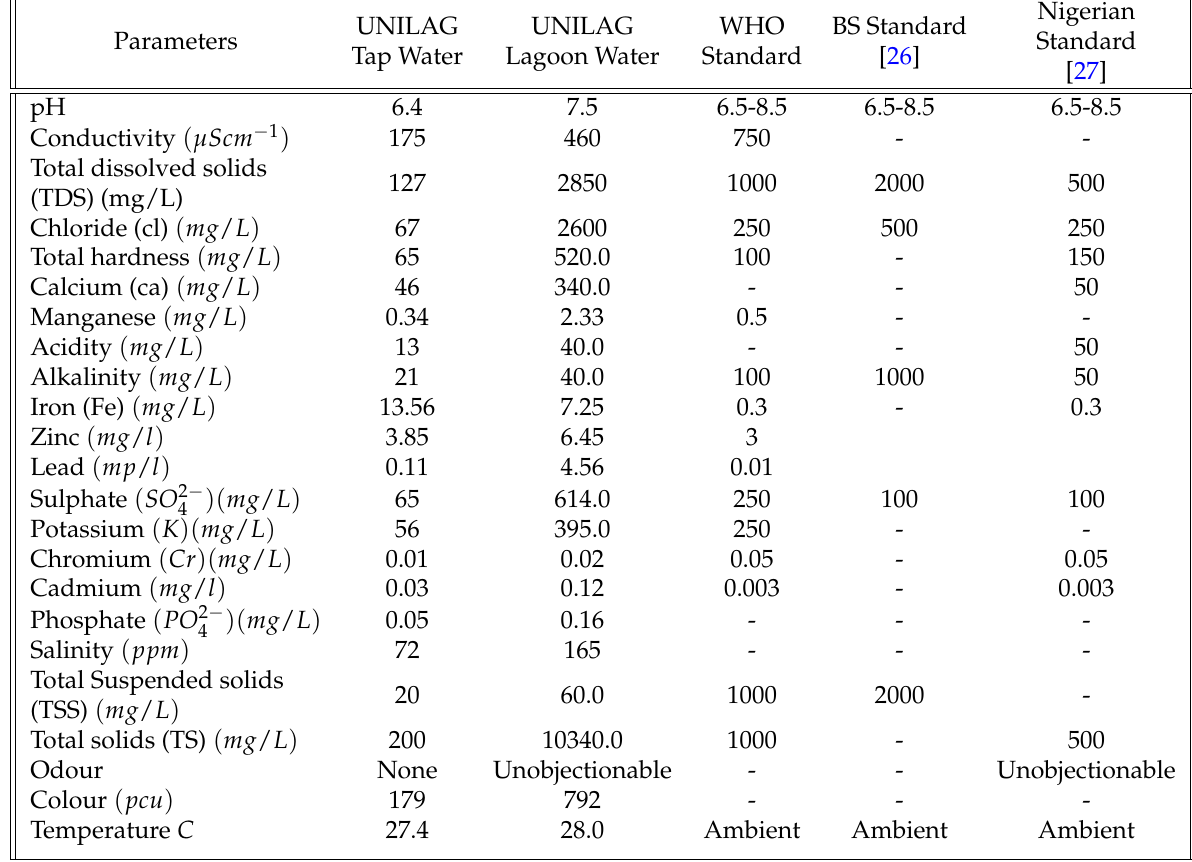
Table 1. Physio-chemical analysis of water samples during the month of august 2018